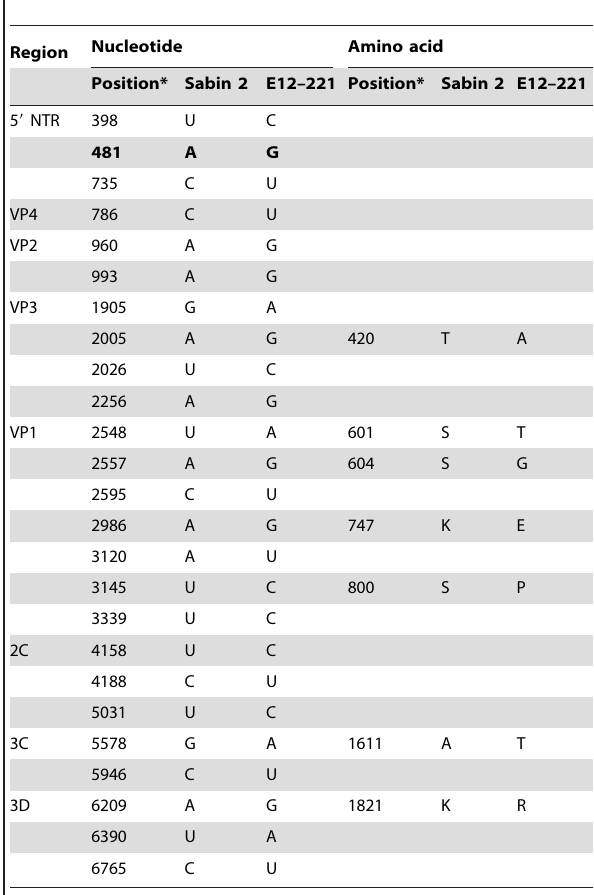
Table 1. Nucleotide and amino acid substitutions in the sewage isolate E12–221 in comparison to Sabin 2.